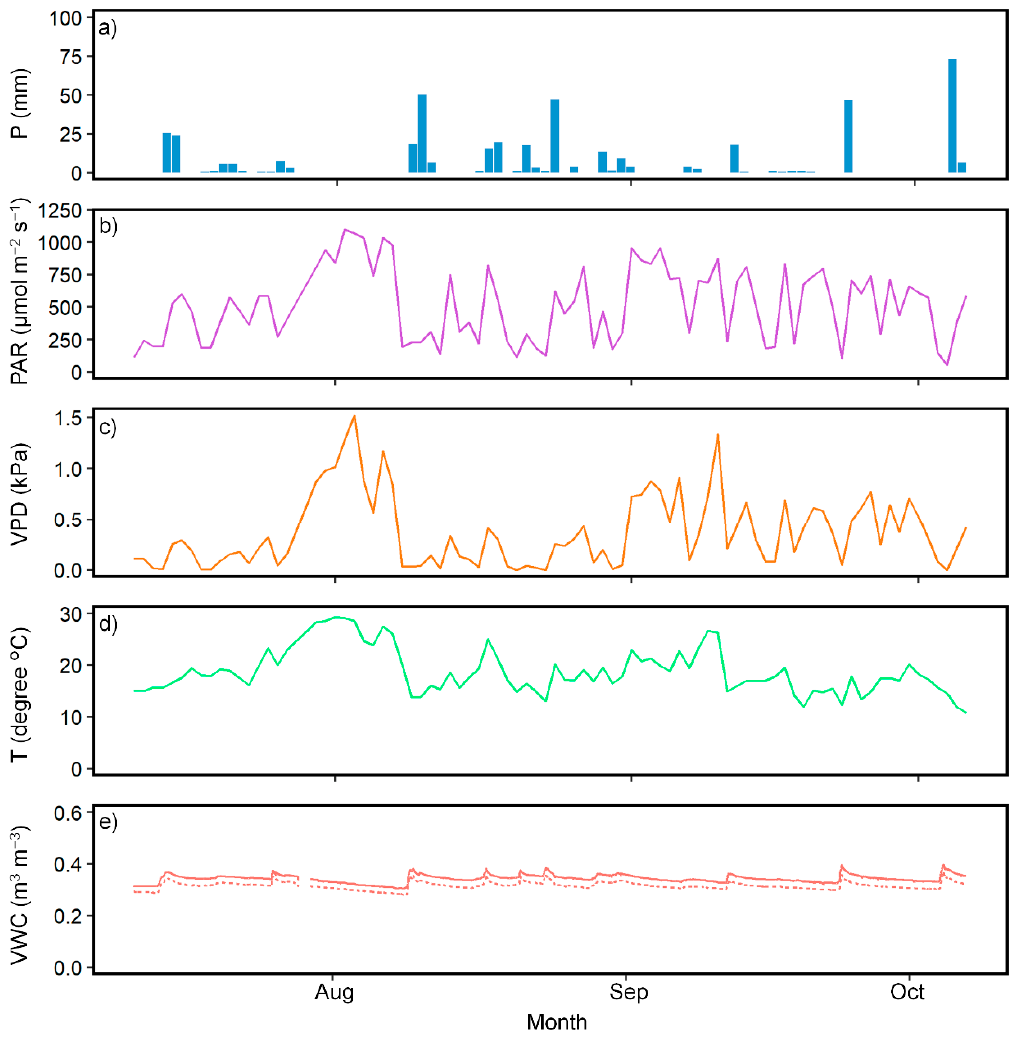
Figure 1. Meteorological conditions and soil moisture from 11 July 2019 to 6 October 2019. ( a ) Daily total amount of precipitation (P). ( b ) The daytime mean photosynthetic active radiation (PAR). ( c ) The daytime mean vapor pressure deficit (VPD). ( d ) The daytime mean temperature (T). ( e ) Weighted averages of volumetric water contents (VWC) per plot. The solid line represents the control, and the dotted line represents the N ‐ fertilized plots. The weighted averages were calculated from the values measured at depths of 10, 20, and 50 cm.